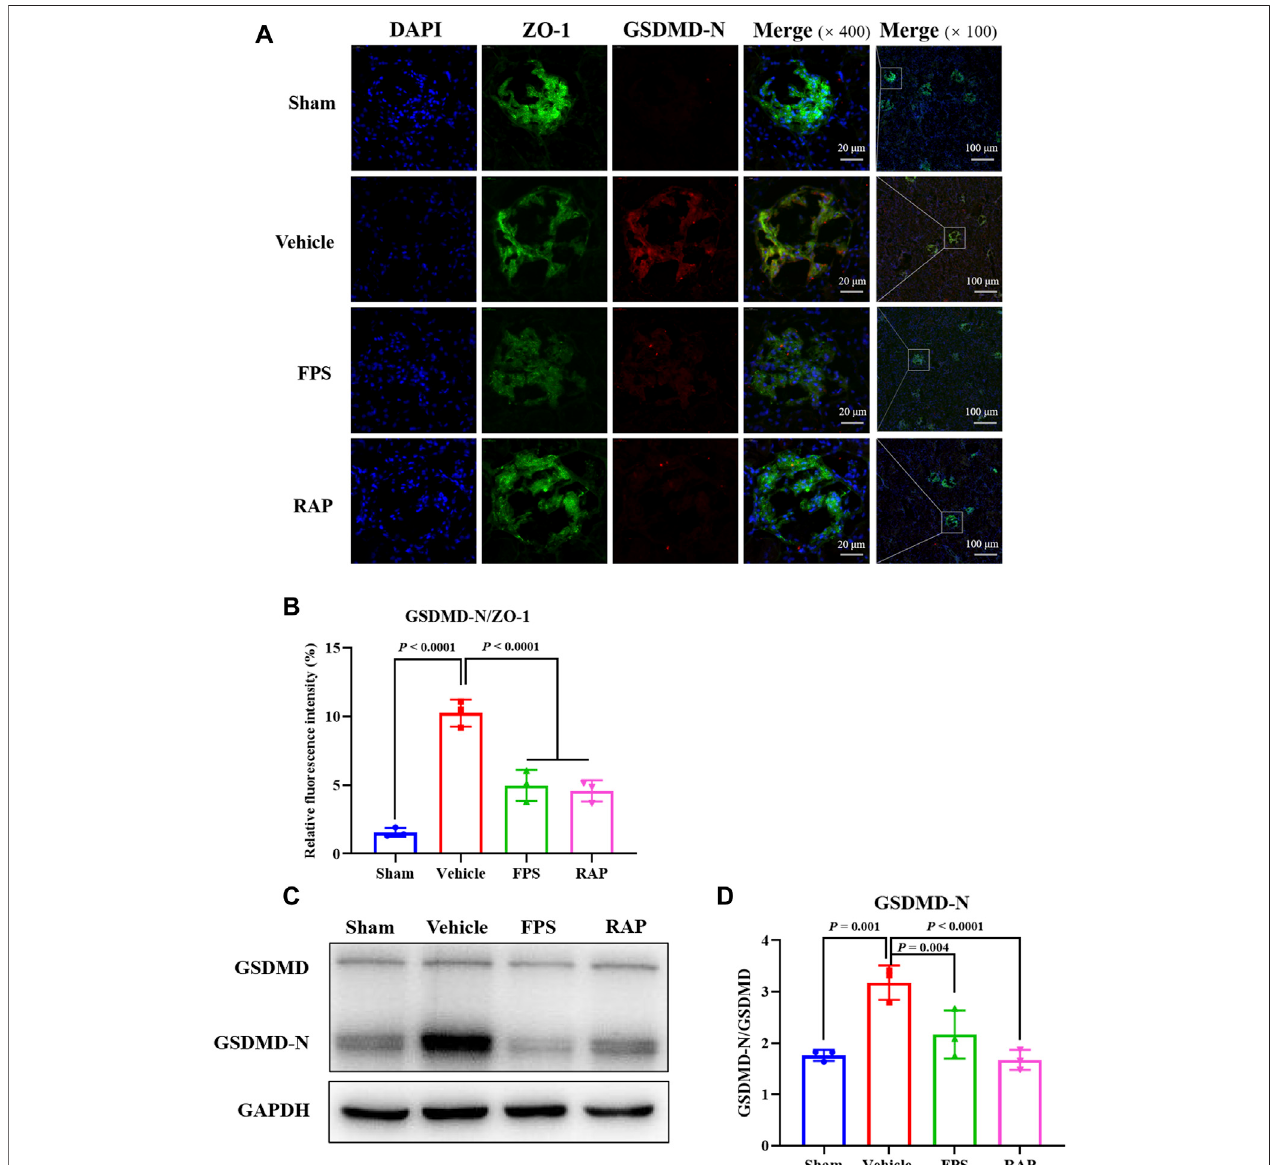
FIGURE 7 | Effects of FPS and RAP on podocyte pyroptosis in vivo . (A) The immuno fl uorescent co-localization of ZO-1 and GSDMD-N in glomeruli. Nuclei counterstainedwith DAPI.Scale bar =20and 100 μ m. (B) The relative fl uorescence intensity ofGSDMD-N/ZO-1. (C) TheWB analysisofGSDMD and GSDMD-N inthe diabetic kidneys. (D) The rate of GSDMD-N to GSDMD. The data are expressed as the mean ± SD.